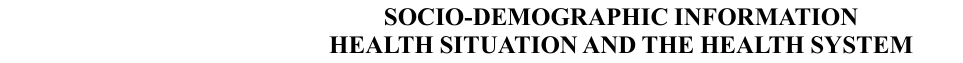
TABLE I - Evaluation indicators of pharmaceutical assistance in Maranhão State